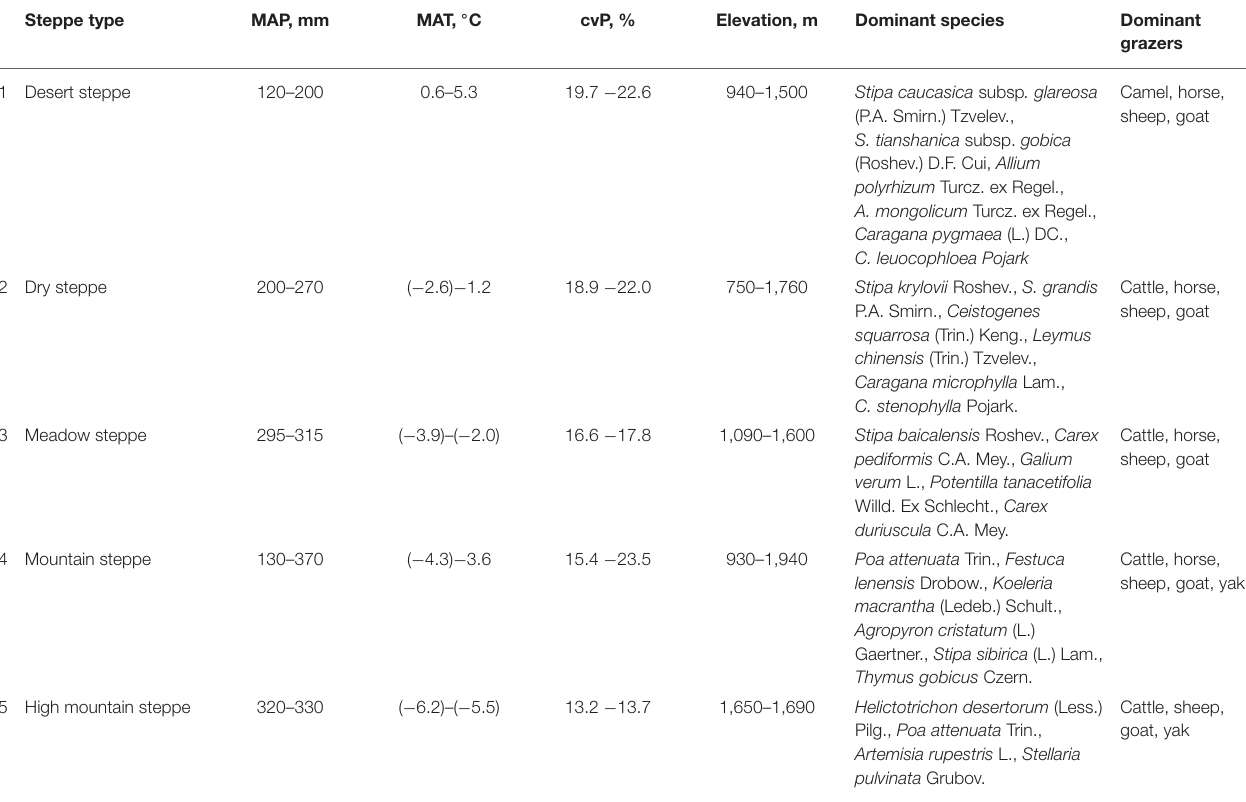
TABLE 1 | Main environmental characteristics, dominant plant species and dominant grazers for five main steppe types in Mongolia. Steppe